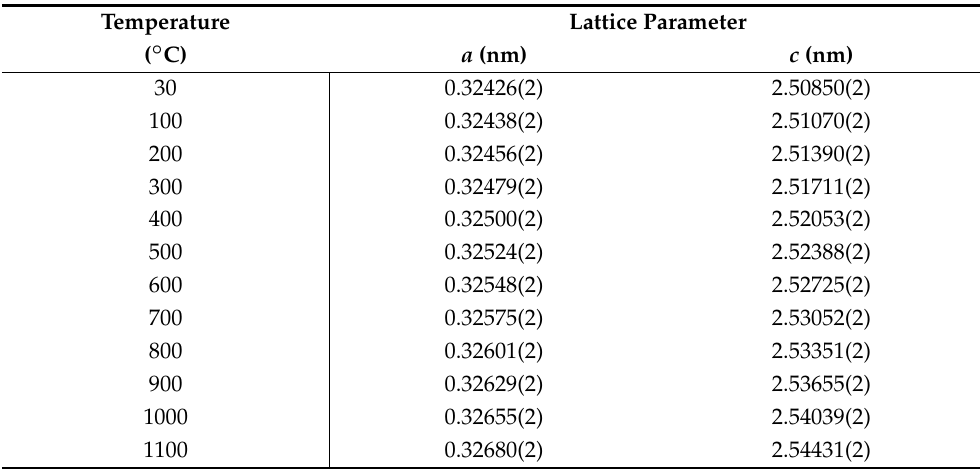
Table 1. Obtained lattice parameters of a - and c -axes for SCAM single crystal with various tempera- tures. The standard errors of the last digit are also shown in brackets.